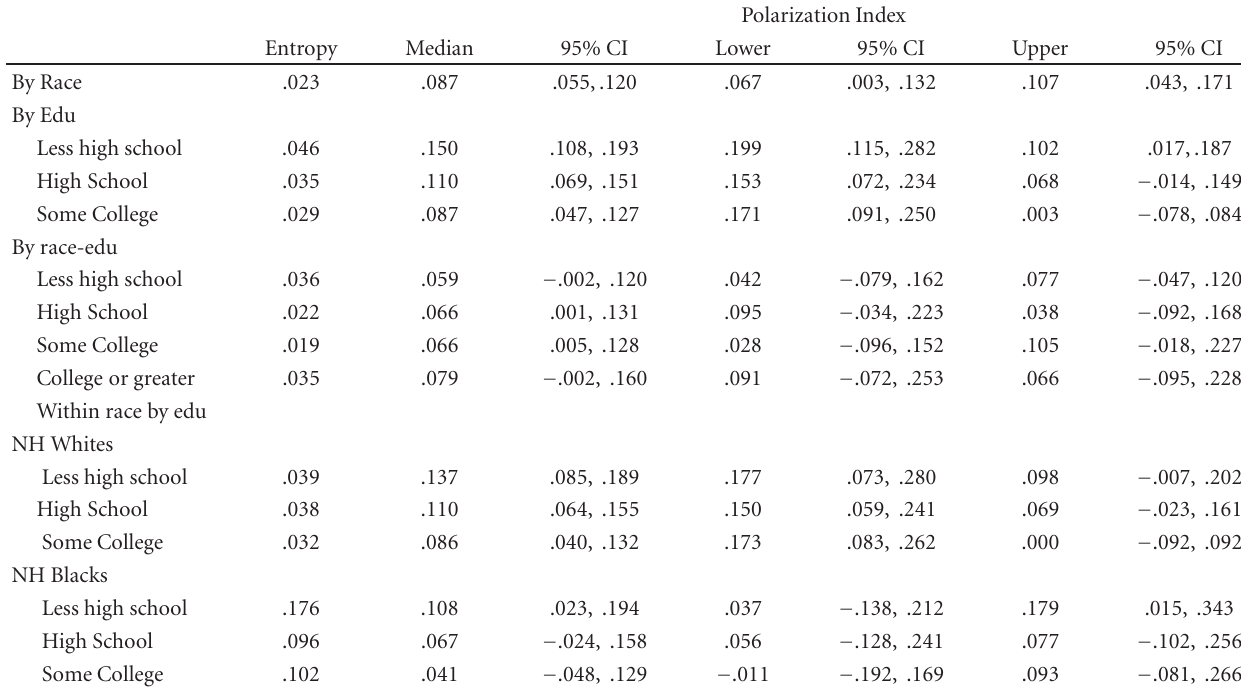
Table 2: Summary measures for distributional comparisons for men, by race, education, and race-education subgroups, United States (1999–2006).